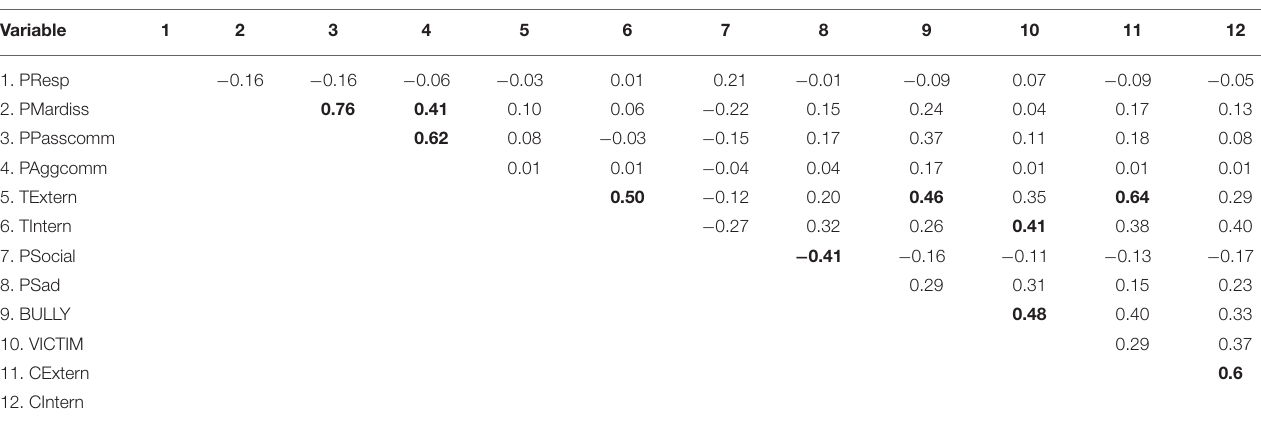
TABLE 3 | Correlation matrix of factors.